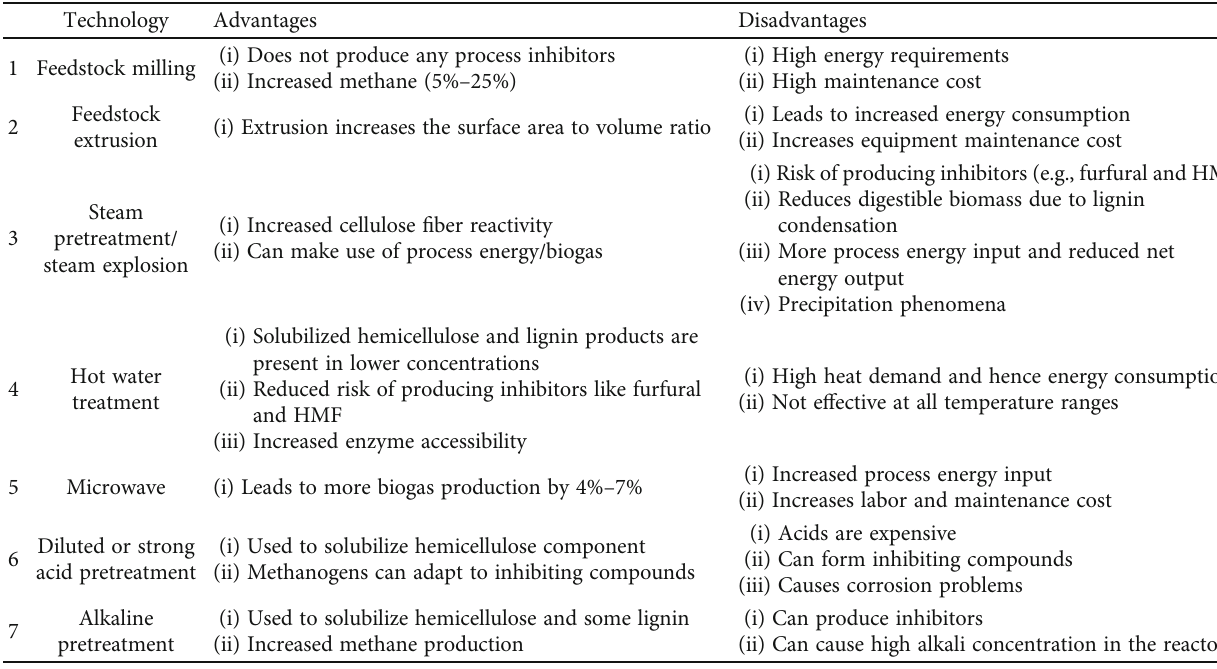
Table 1: Pretreatment methods and applications